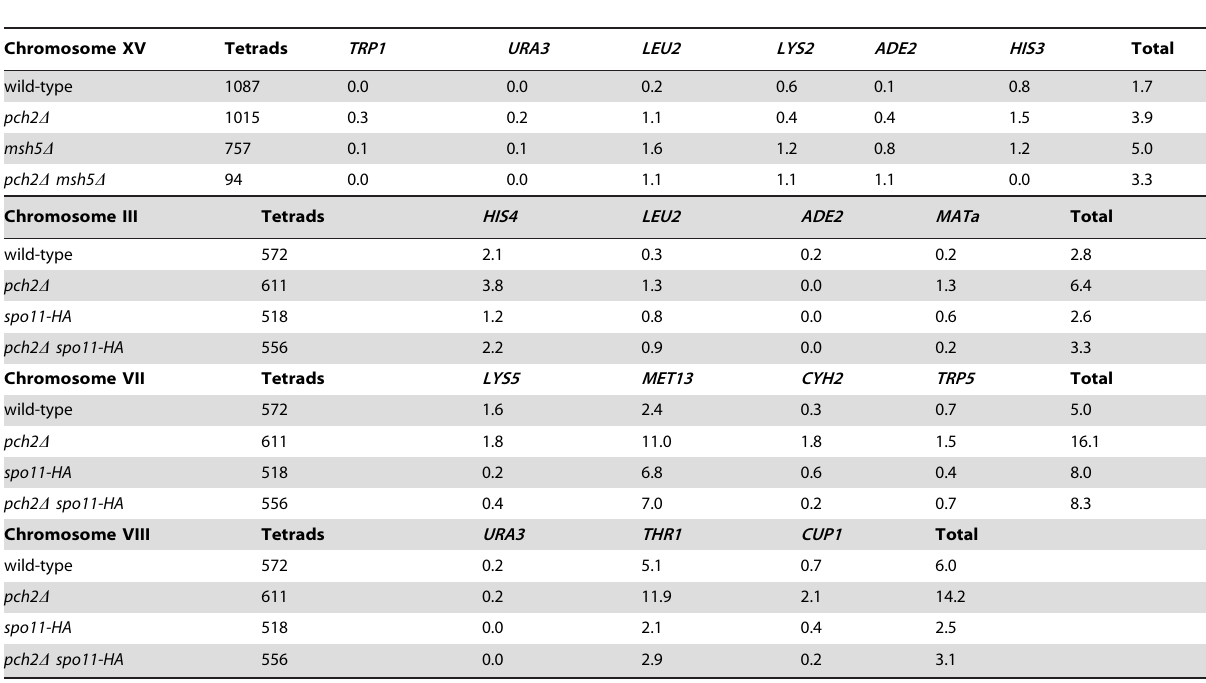
Table 2. pch2 D increases the frequency of aberrant marker